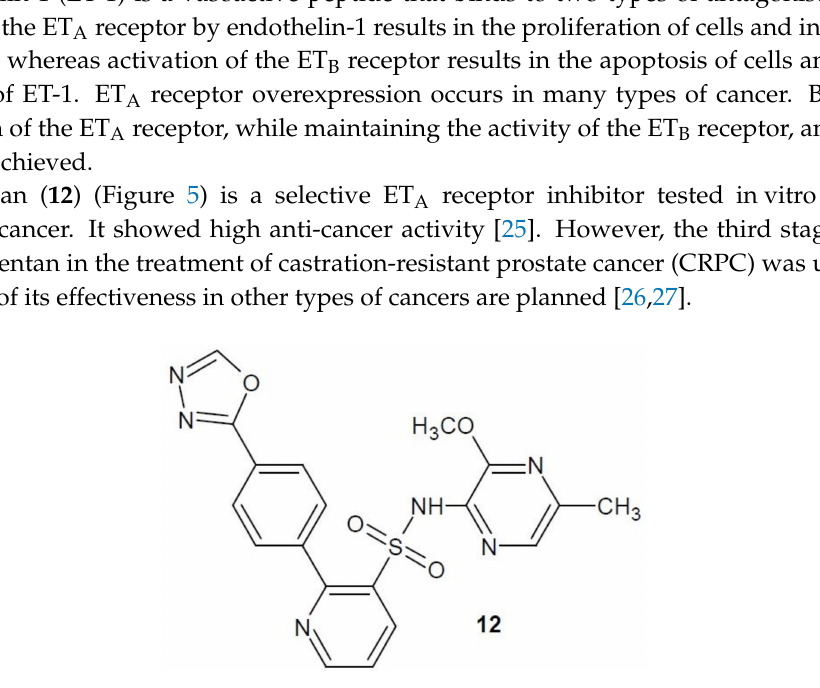
Figure 5. Zibotentan with activity of endothelin receptor